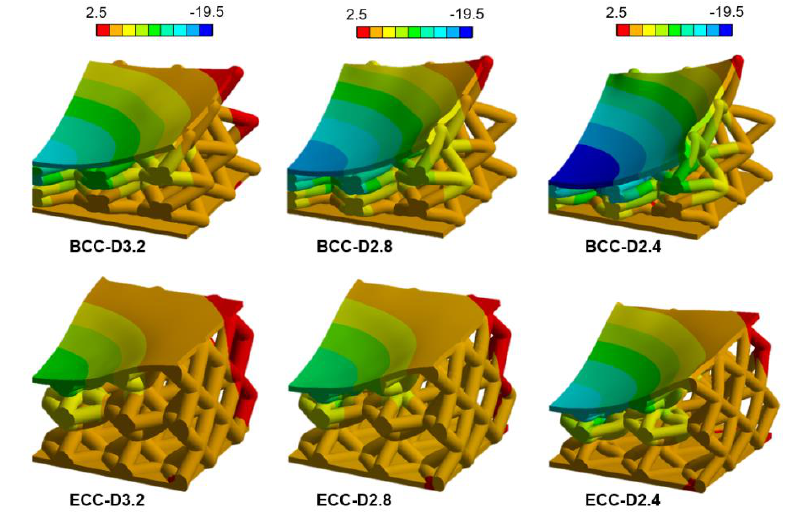
Figure 9. The maximum deformation of the sandwich structures with six types of lattice core under dynamic impact.